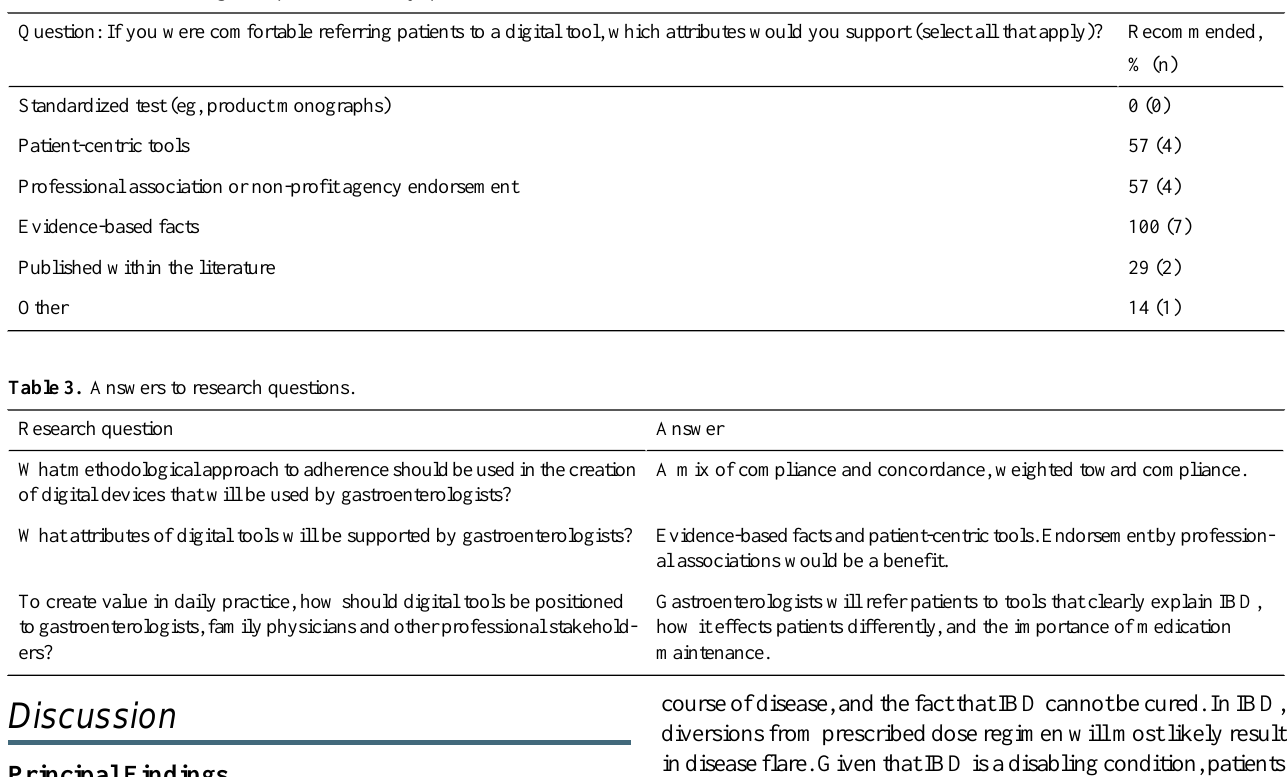
Table 2. Gastroenterologist responses to survey question (N=7).